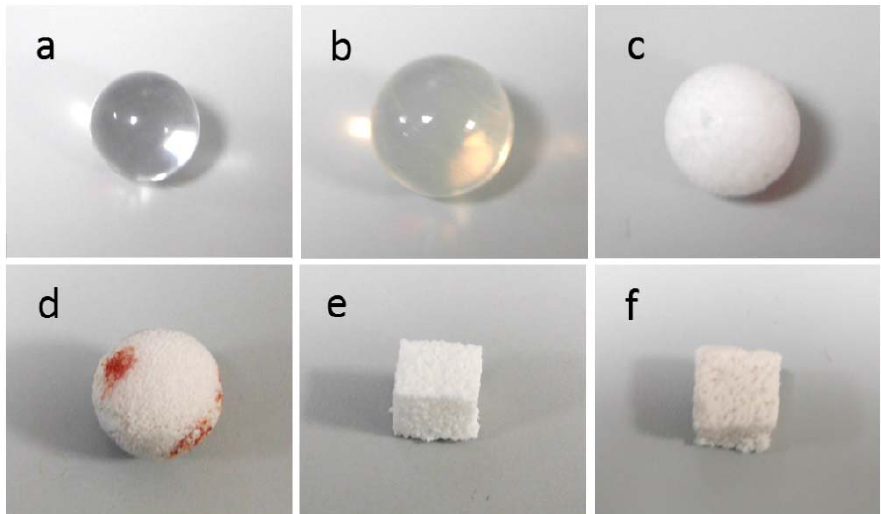
Figure 2. Pictures of the samples analyzed in this work: ( a ) non-porous PMMA; ( b ) non-porous silicone; ( c ) porous PE; ( d ) porous alumina (red pen marks were done as reference positions to make it easier to find the struts and land onto them with the atomic force microscope (AFM) probe tip, instead of sinking into the macropores); ( e ) porous GCA; ( f ) porous GCB. Implant dimensions are summarized in Table 1.